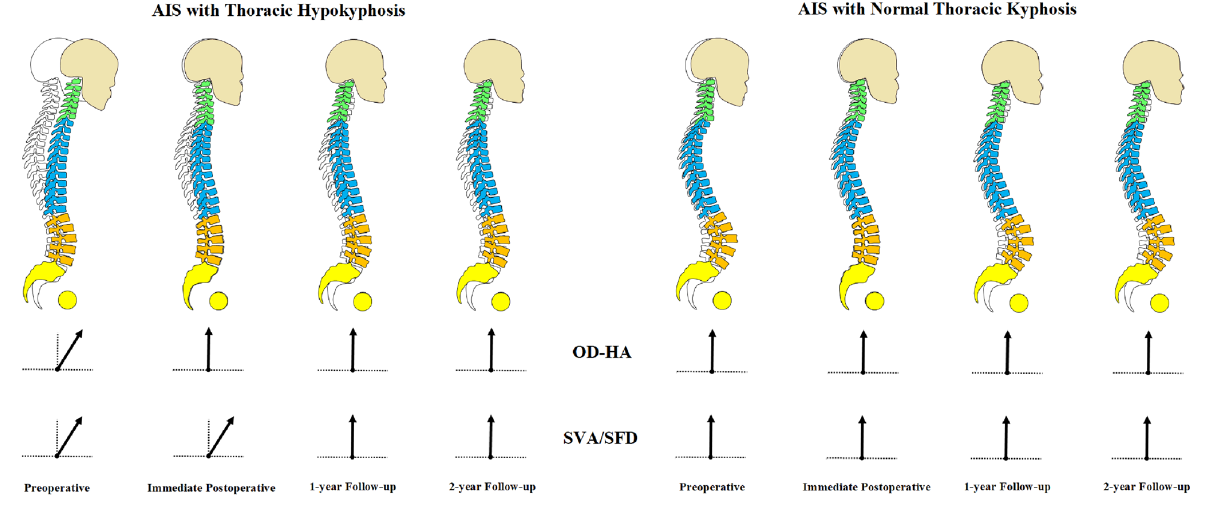
Figure 3. The schematic diagram on the evolution of changes in the global sagittal profiles of AIS patients with and without thoracic hypokyphosis pre-operative and at different time points post-operative. In AIS patients with thoracic hypokyphosis, the overall balance is compensated with the unusually forward leaning posture (head forward) in pre-operative stage. This posture is corrected with modification during different stages post- operatively. Whereas in AIS patients with normal thoracic kyphosis, the overall balance is maintained with head in a relatively neutral position. There is no significant interval change of the thoracic kyphosis at any time point. The spinal profiles are superimposed on a non-scoliotic spine. The arrow represents the overall balance of the corresponding parameters at each time point: ↗ , leaning forward; ↑ , medial